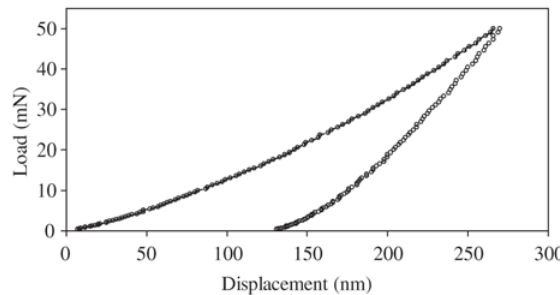
Figure 5. Load-displacement curve obtained experimentally for an alumina (Al O ) 2 3